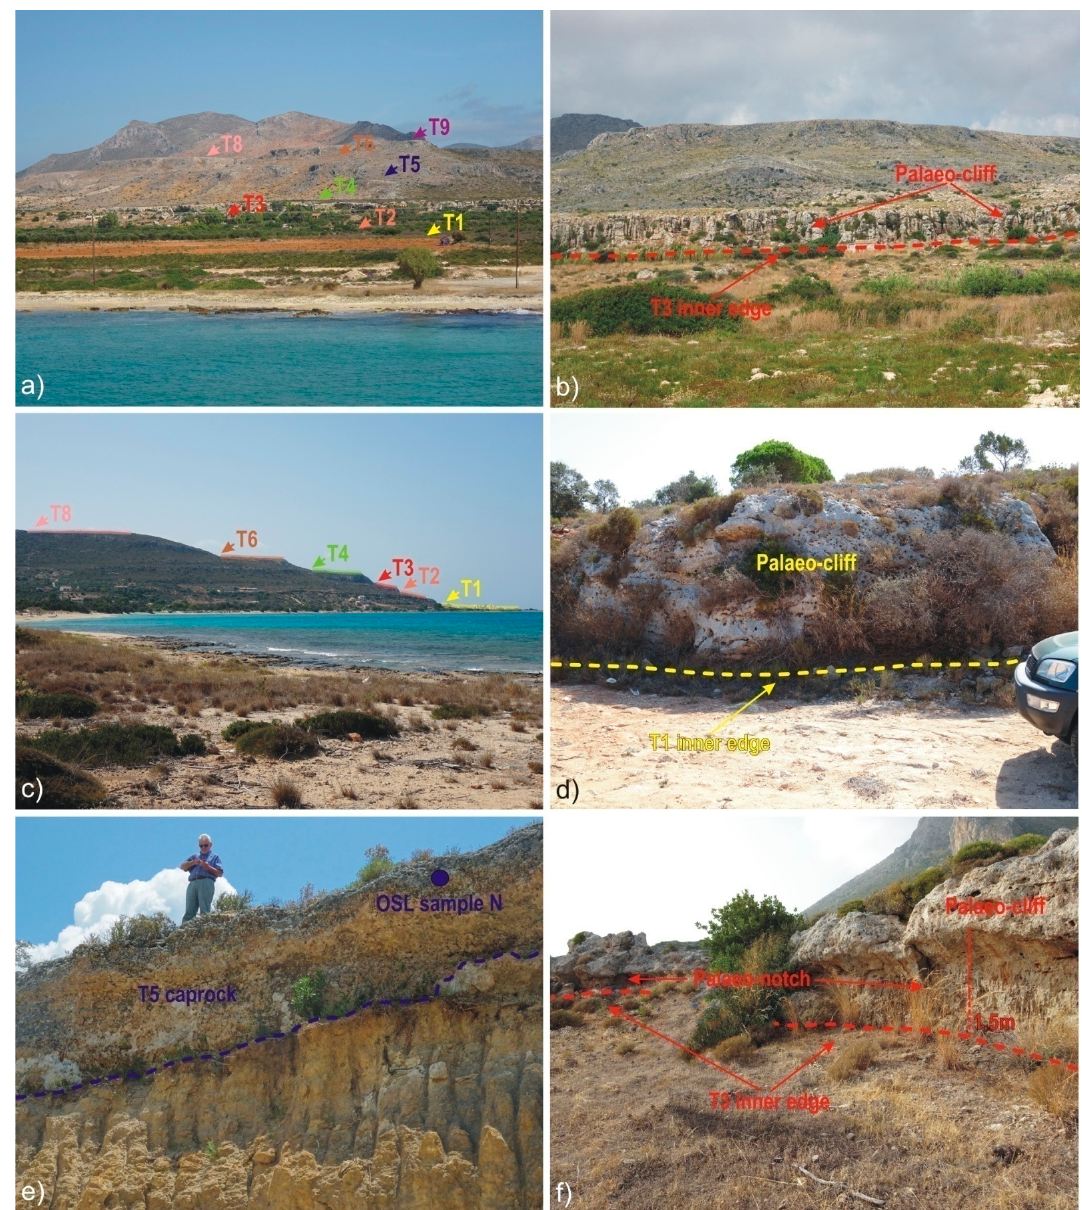
Figure 5. ( a ) View of the flight of marine terraces northwest of Cape Punta. Colored arrows (same colors as Figure 4) point to terraces T1, T2, T3, T4, T5, T6, T8, and T9 ( b ) View of the paleo-shoreline angle of terrace T3 (corresponding to MIS 5e sea-level highstand) north of Cape Punta. ( c ) Profile view of the terrace sequence on the western part of the Elafonissos Island ( d ) View of the inner edge of terrace T3 (corresponding to MIS 5a sea-level highstand) at the north part of Elafonissos. ( e ) Outcrop of Terrace T5 caprock, northwest of Cape Punta. The position of the sedimentary block sample N collected for OSL dating is also depicted ( f ). View of the inner edge of terrace T3 (corresponding to MIS 5e sea-level highstand) northeast of Profitis Ilias.